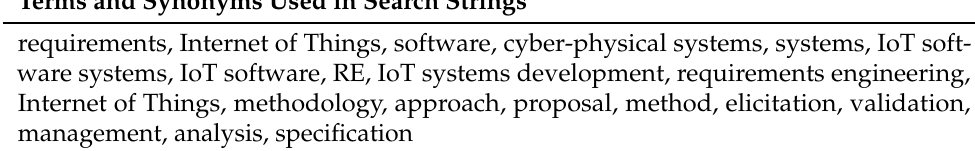
Table 1. Search terms used in the construction of search